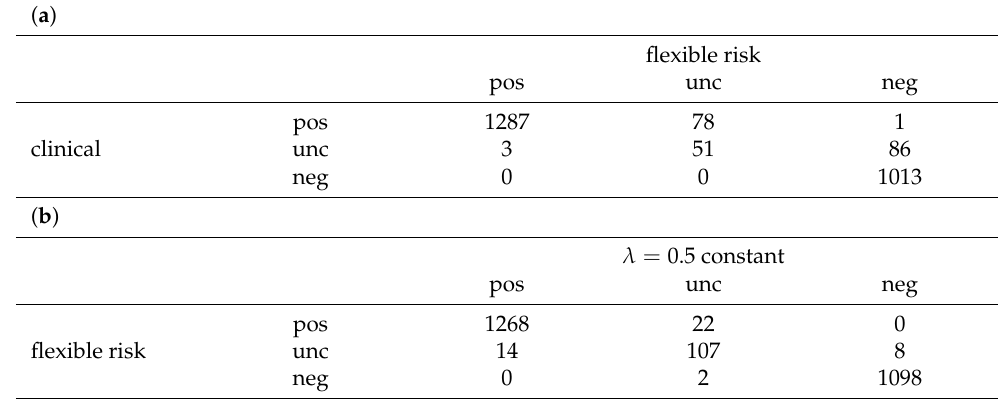
Table 1. Clinical decision making vs. flexible risk: ( a ) change from clinical decision making to Formula (9), κ = 0.877, there is a trend towards receptor negative (upper triangular matrix). ( b ) an influence of λ is only given for numerically problematic samples, κ =